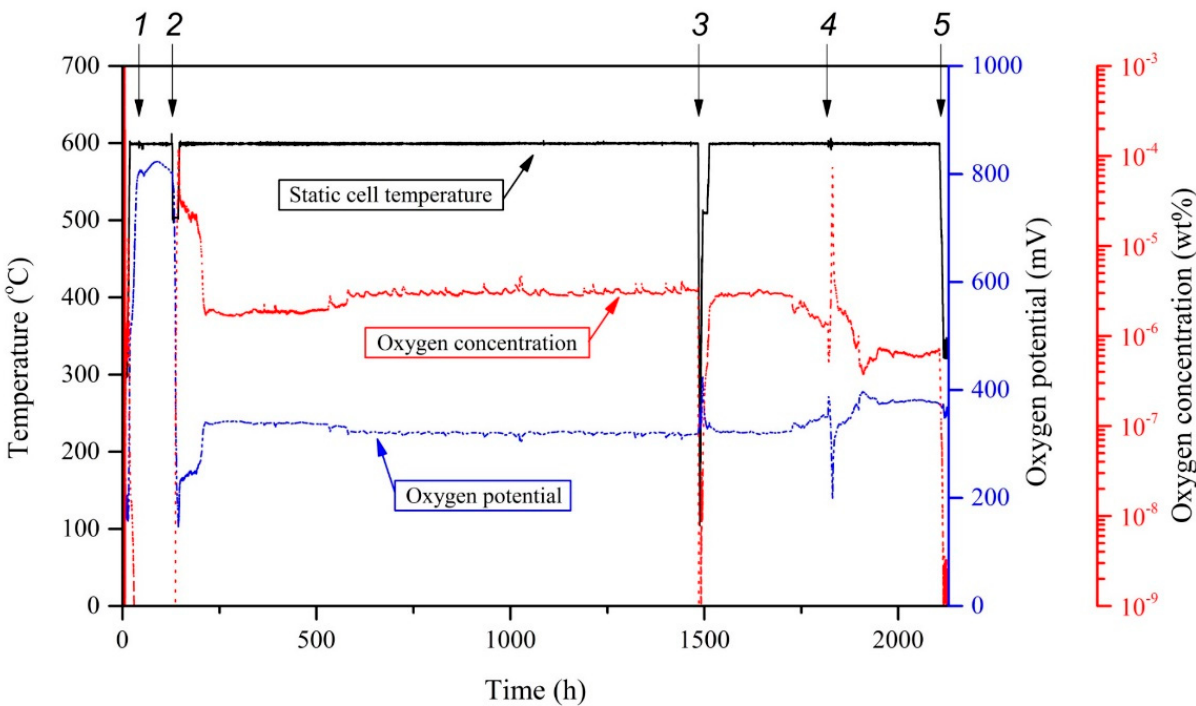
Figure 4. History of LBE temperature and oxygen potential/concentration in a static cell during corrosion tests at 600 °C. The above numbering corresponds to the numbers in Figure 4.